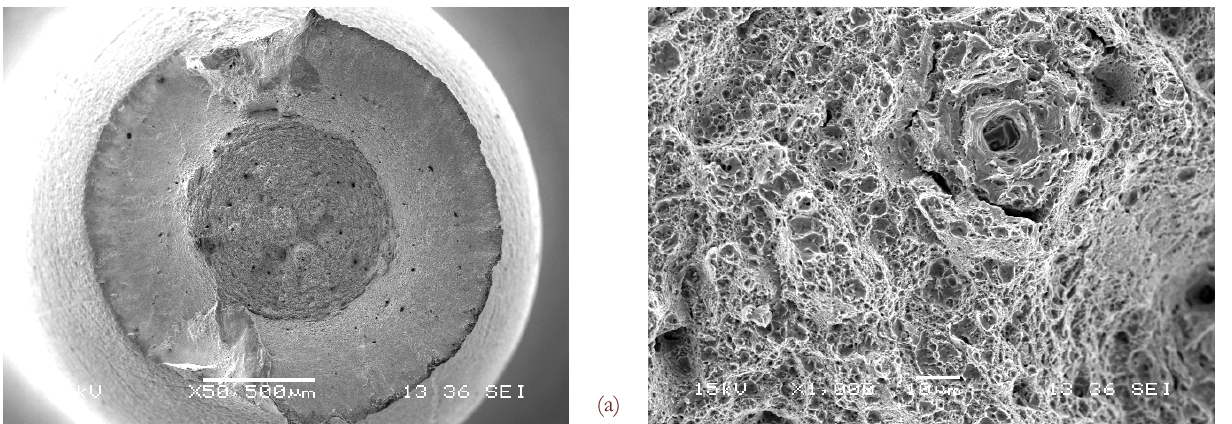
Figure 8: (a) Fracture surface for Maraging 250 specimen peak-aged at 535°C and (b) X1000 magnification for test in air.